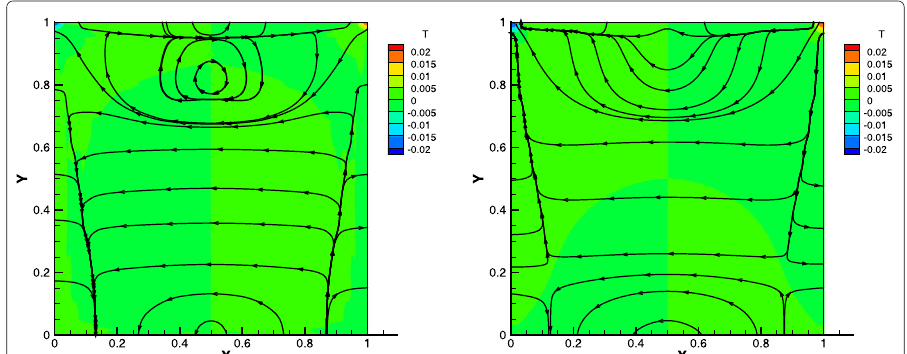
Fig. 20 The heat flux and temperature contour of the lid-driven cavity flow with Knudsen number 10 − 4 . Left